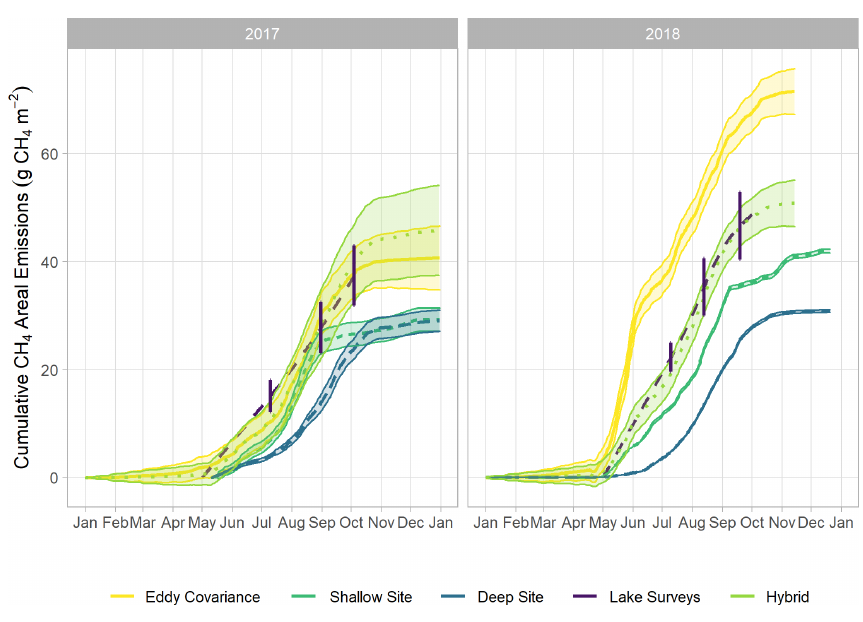
Figure 5. Cumulative areal emissions in 2017 and 2018 from EC, sum of AFT and chamber, spatial survey monitoring, and hybrid upscaling results (gCH 4 m − 2 ). Vertical lines intersecting the lake survey trace represent the 95% confidence interval of the lake-wide F CH